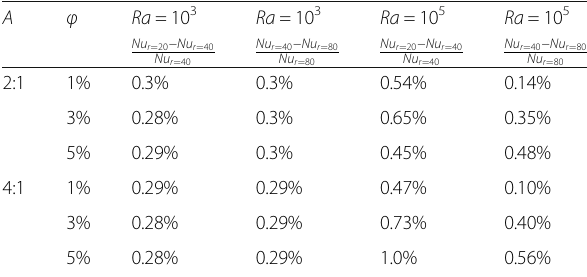
Table 6 Nusselt number enhancement ratios. Nusselt number enhancement ratios for every nanoparticle radius reducing by